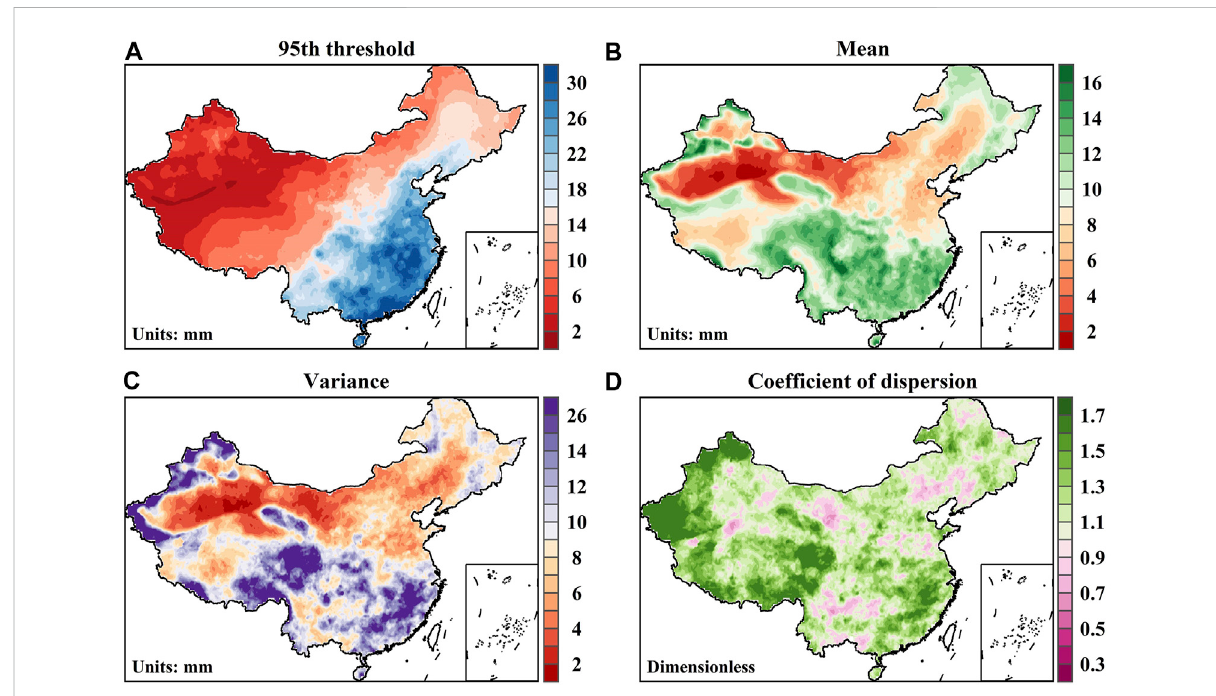
FIGURE 1 Information of peak-over-threshold (POT) sampling for extreme precipitation: (A) 95th percentile of non-zero precipitation as the threshold in POT sampling; (B) annual average days with precipitation exceeding this threshold; (C) the variance of annual number of days with precipitation exceeding this threshold; and (D) the coef fi cient of dispersion (i.e., the variance divided by the mean).